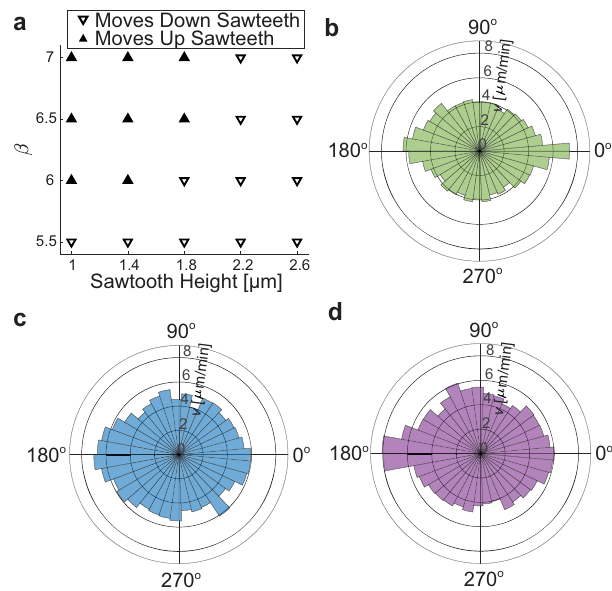
Fig. 5 Asymmetric sawteeth preferentially guide cells with high velocities. a A phase diagram demonstrating dependence of guidance direction on β and sawtooth height on a cell initially polarized up the sawteeth in the phase- fi eld simulations. The average velocity distributions derived from experimental data for D. discoideum on asymmetric sawteeth of three different heights: ( b ) 1 μ m, ( c ) 1.8 μ m, and ( d ) 2.4 μ m. For the 1 μ m sawteeth, the distribution peaked at 0 ∘ , indicating that the faster cells are guided preferentially up the sawteeth. This observation is consistent with the phase diagram in ( a ), in which cells with higher actin polymerization rates are guided up the sawteeth. For sawtooth heights of 1.8 μ m and 2.4 μ m, the velocity distribution peaked at 180 ∘ , indicating that the faster cells move preferentially down the